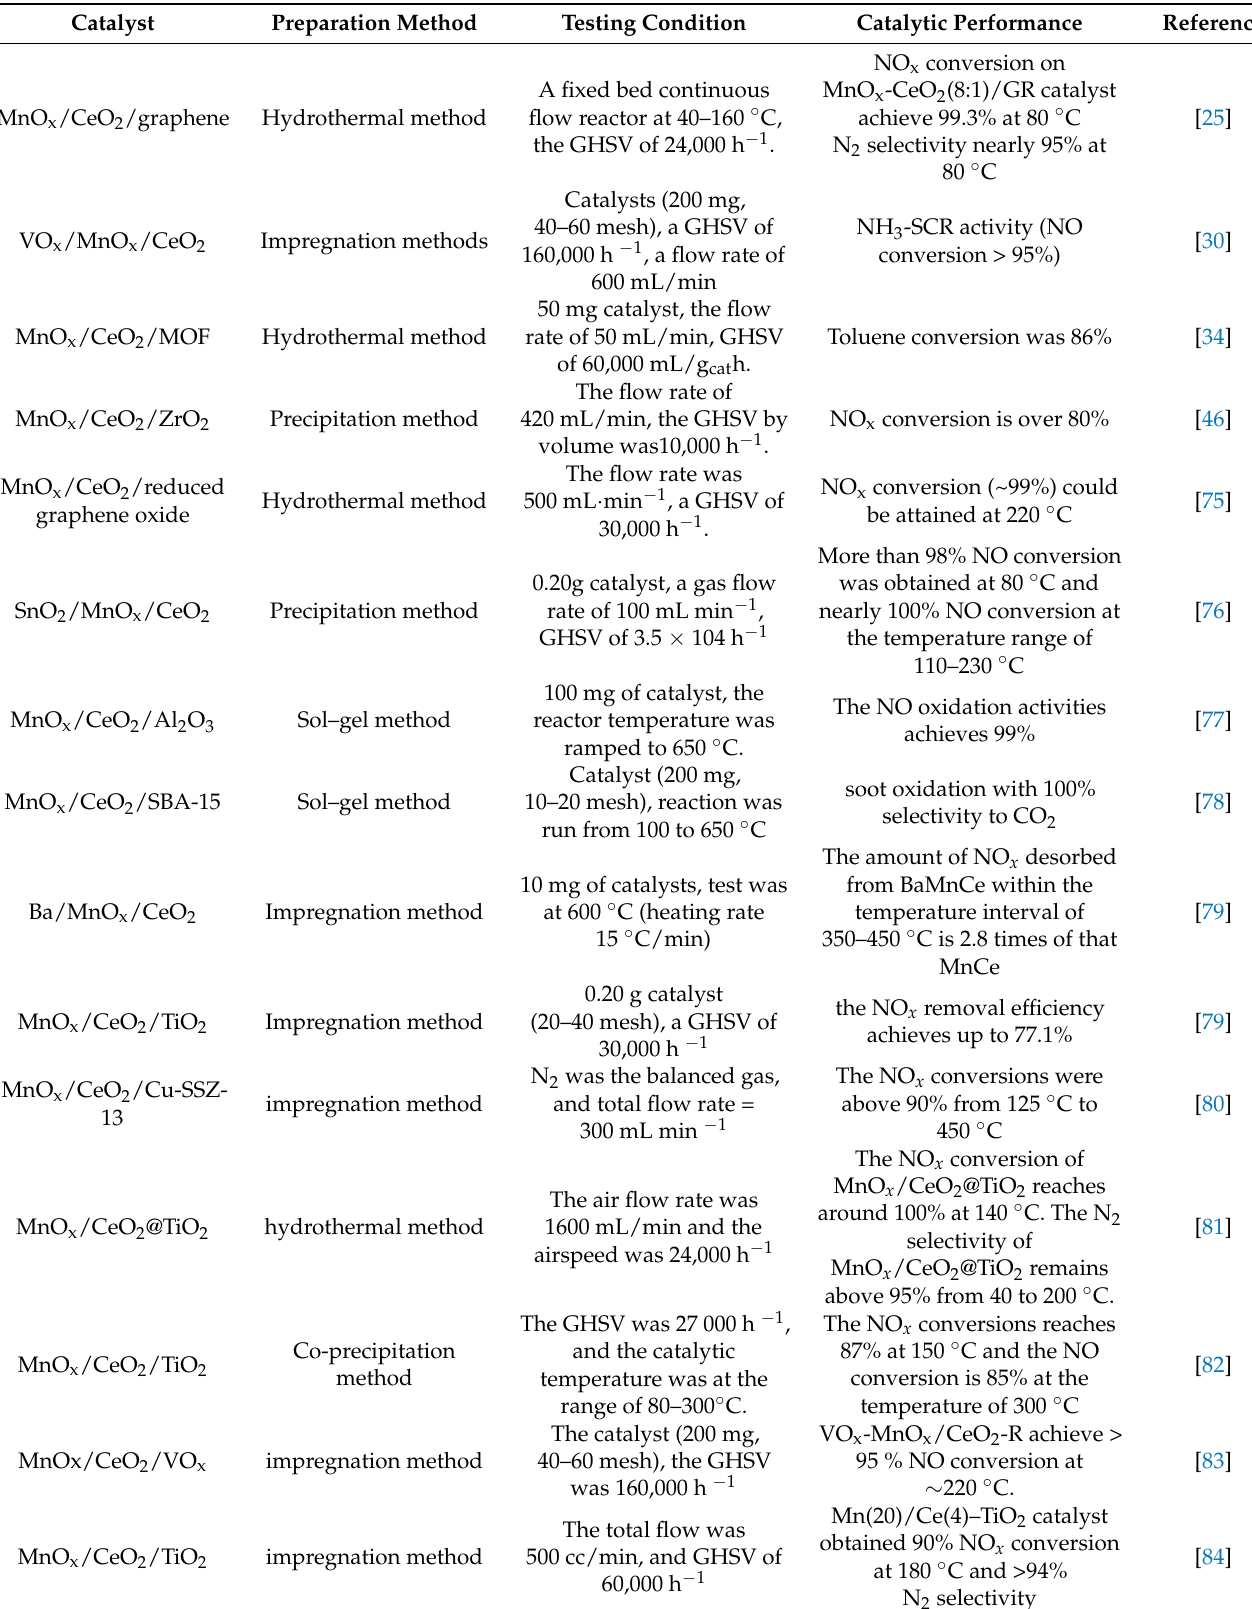
Table 2. Summary of MnO x /CeO 2 -based ternary catalysts for NO x